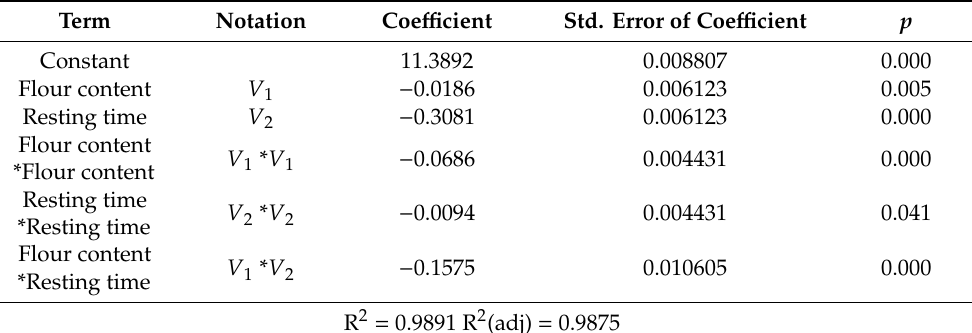
Table 9. Moisture content value for di ff erent flour content and dough resting